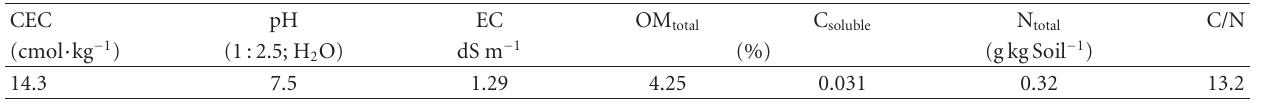
Table 1: Physicochemical characteristics of the Typic Hapludoll soil. All data are expressed as dry basis (DM). Clay Silt Sand Texture CEC pH EC OM total C soluble N total % cmol · kg − 1 1:2.5; H 2 O dS m − 1 % g kg Soil − 1 19.2 23.2 57.6 Sandy loam 22.1 5.19 0.57 1.92 1.45 2.2